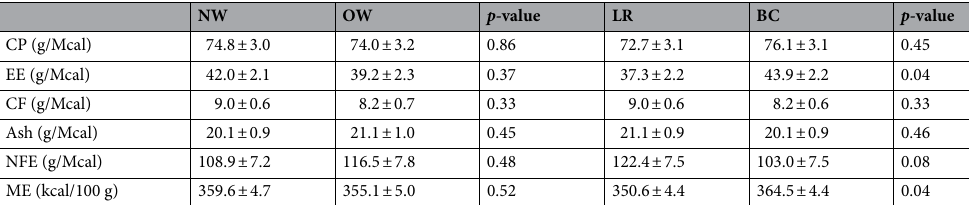
Table 2. Characteristics of the dry foods (n = 26/29) consumed by the recruited dogs (lean, NW, n = 14; overweight, OW, n = 12; Labrador Retrievers, LR, n = 13; Border Collies, BC, n = 13). Data (g/1000 kcal; kcal/100 g) are given as LSmeans ± SE. CP, Crude protein; EE, ether extract; CF, crude fibre; NFE, Nitrogen-free